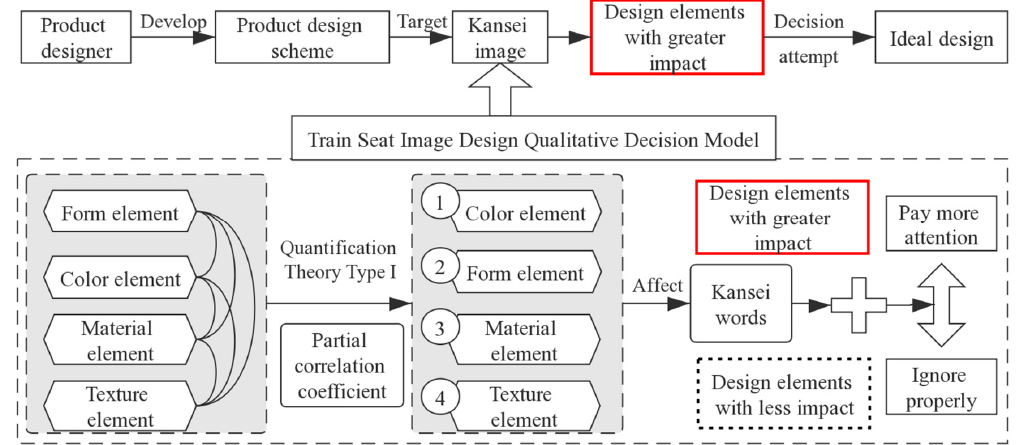
Figure 11. The qualitative decision model of train seat image design.